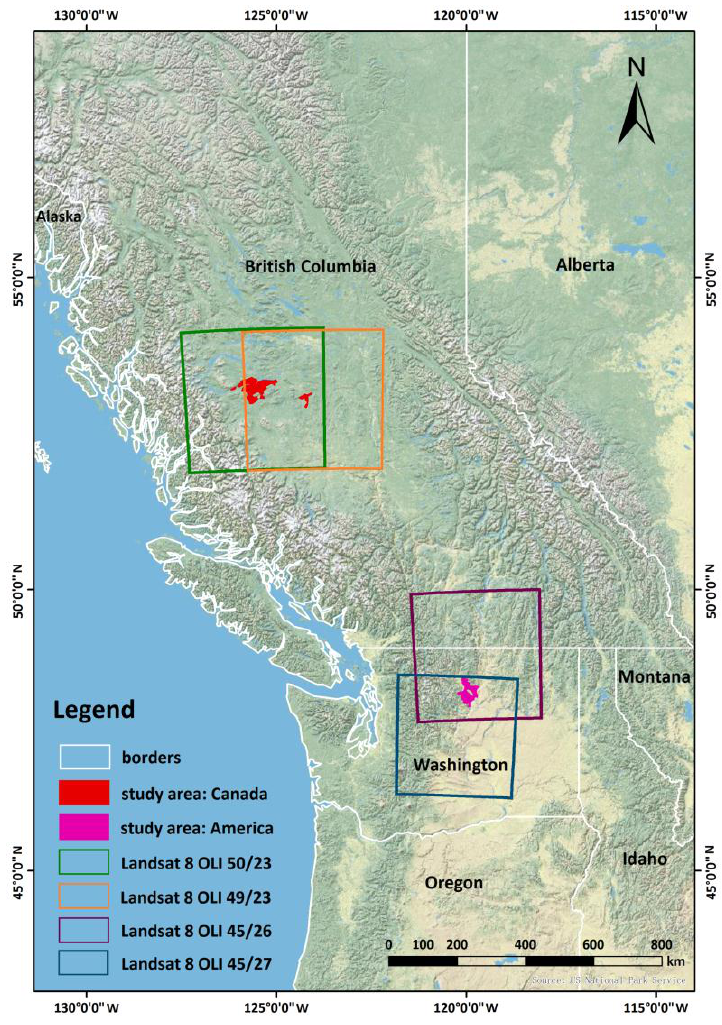
Figure 2. Two study areas and Landsat 8 OLI datasets acquired for validation.